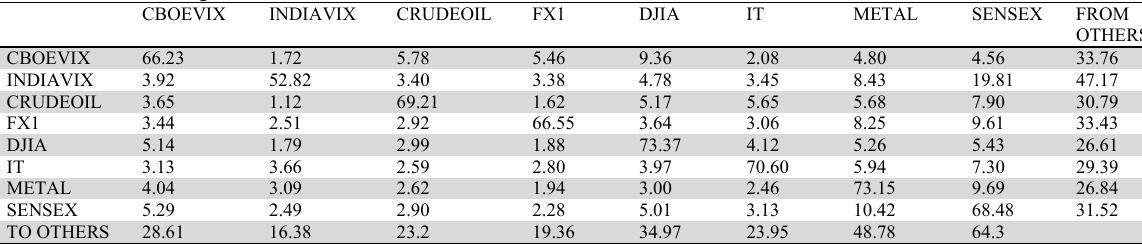
Diebold-Yilmaz Spillover at D1 Scale CBOEVIX